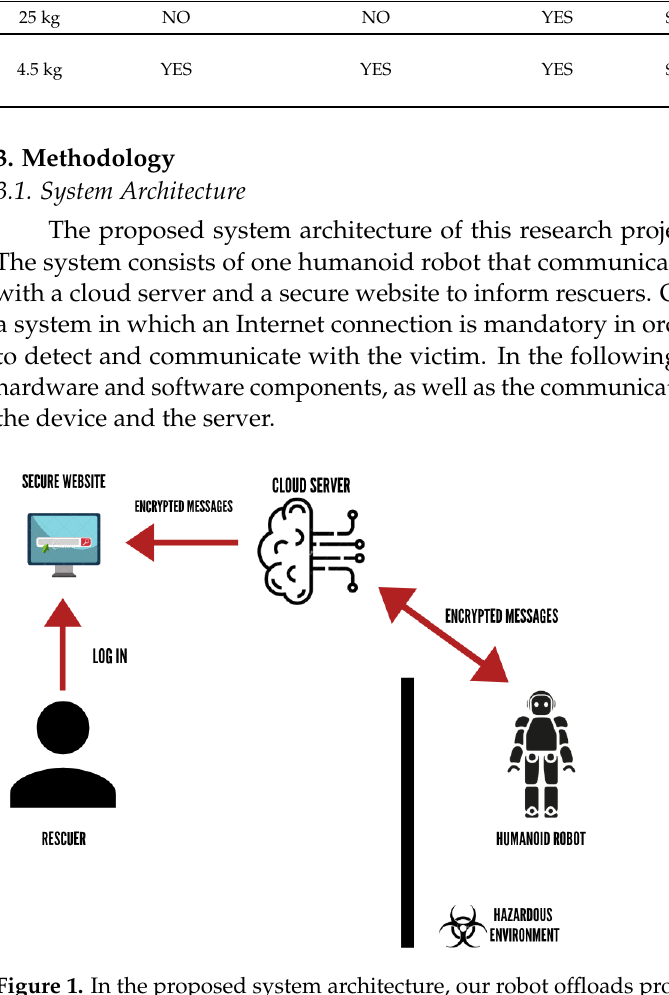
Figure 1. In the proposed system architecture, our robot offloads processing tasks to a cloud